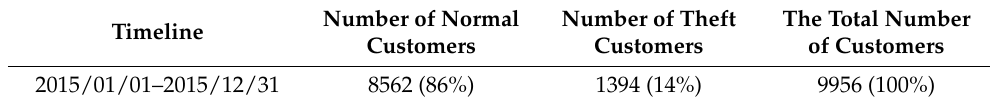
Table 1. The Description of